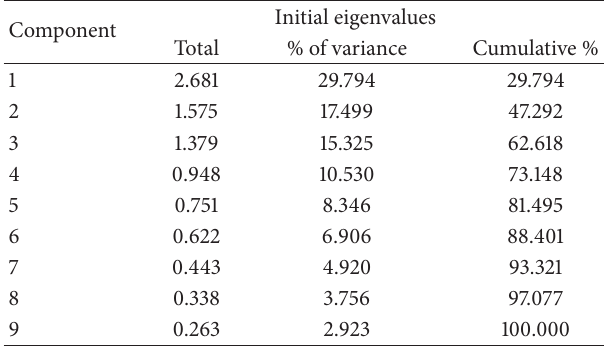
Table 4: Eigenvalues extracted by the principal component